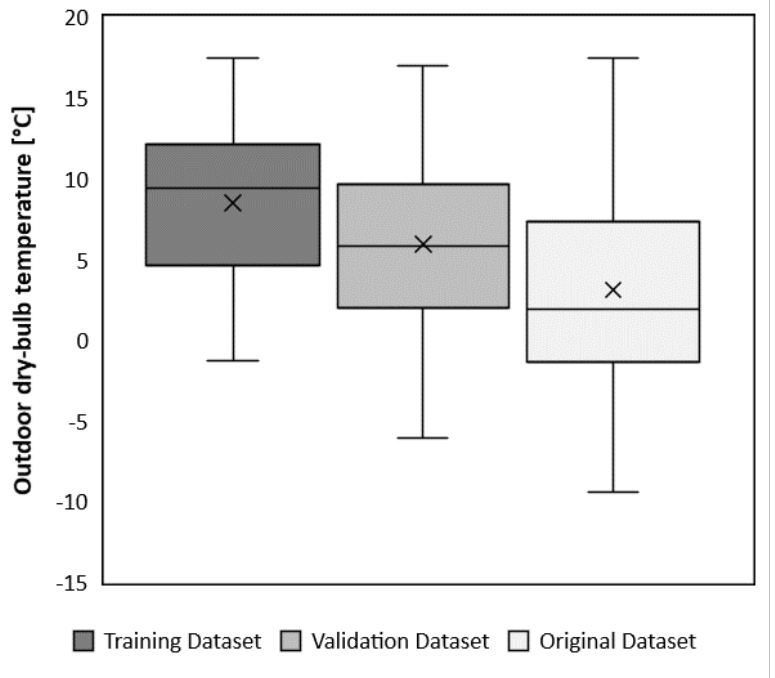
Figure 16. The dispersion of the independent variables in the prediction model, for each dataset used in the